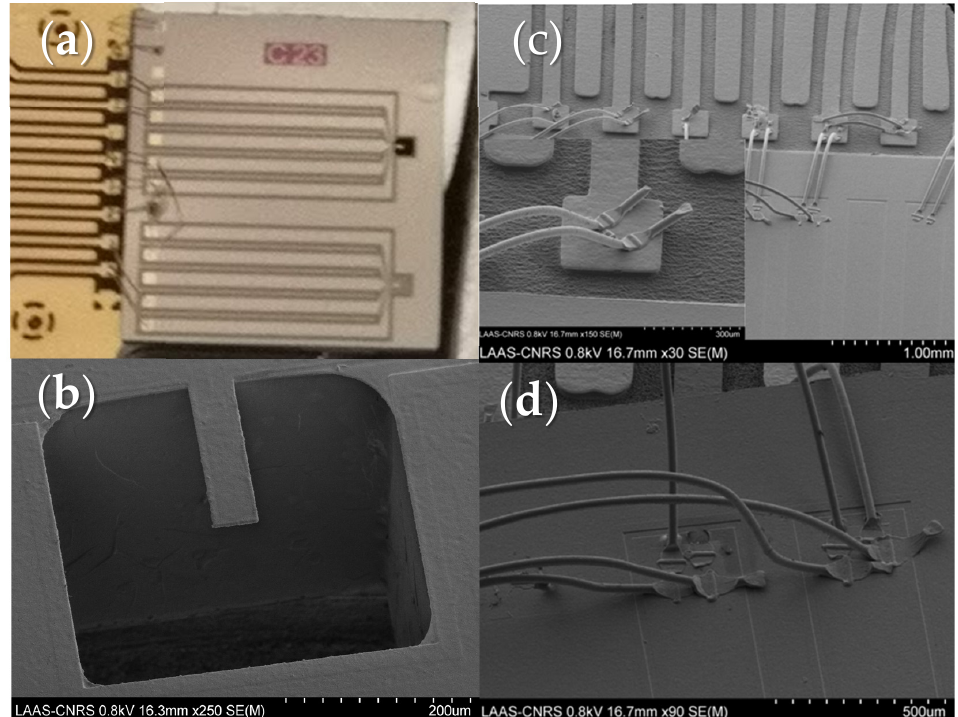
Figure 1. ( a ) Photograph of the MEMS device. ( b ) SEM image of a silicon micro-cantilever coated by the [Fe(Htrz) 2 (trz)](BF 4 )@P(VDF-TrFE) composite film. ( c , d ) Larger scale SEM images showing the MEMS, the PCB and the bonding wires, which are also uniformly